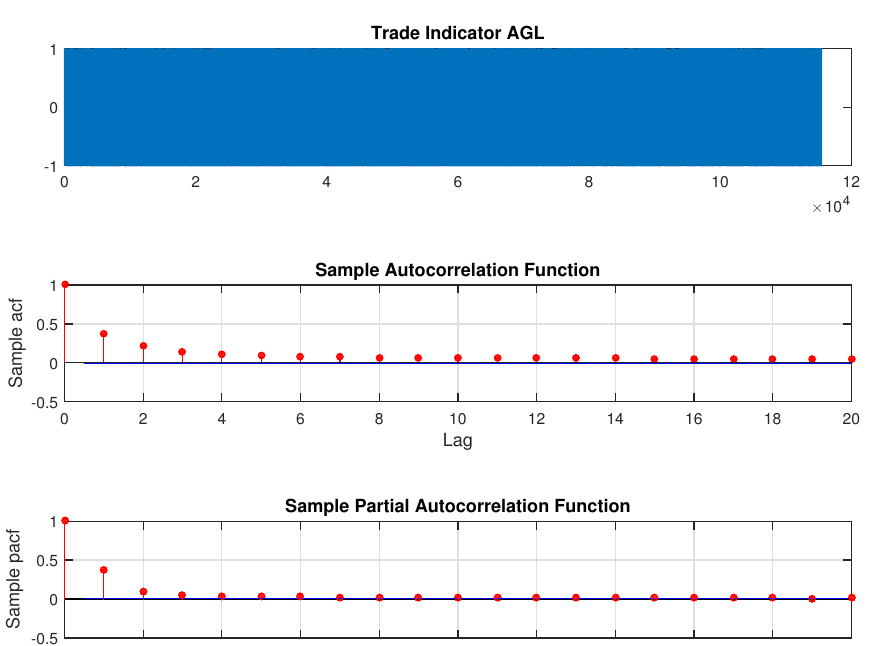
Figure 2. Time series, acf and pacf for spread of AGL.